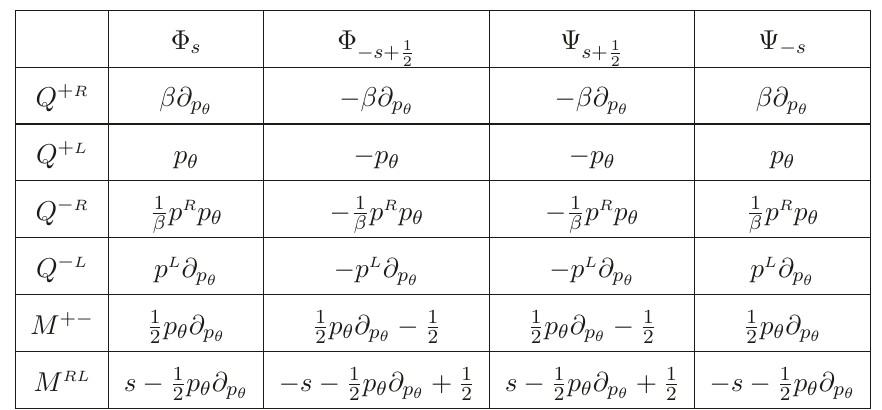
Table 1 . Realization of supercharges (3.14) , (3.15) on superfields (3.2) – (3.4) . Realization of the Poincar´e algebra on superfields (3.2) – (3.4) is given by relations (3.8) – (3.12) , where the operators M + − , M RL should be replaced by operators M + − , M RL given in this λ λ